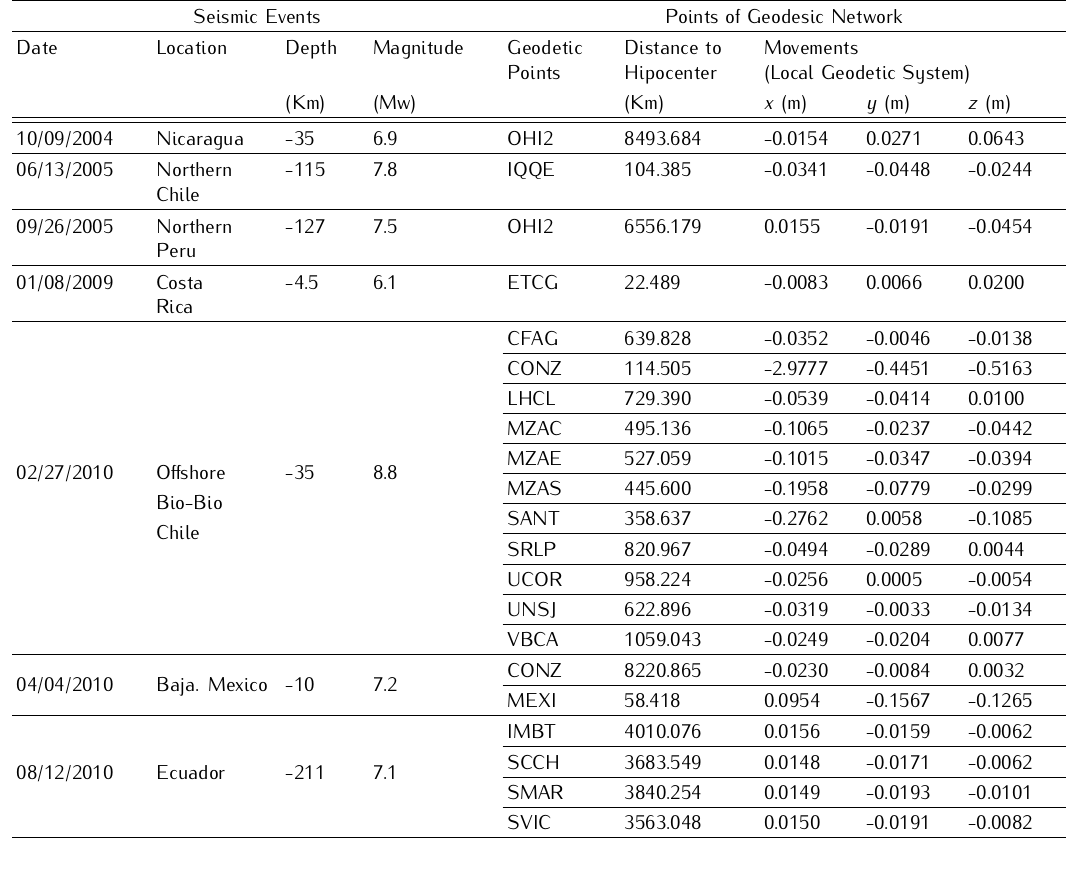
Table 2. Points of the SIRGAS-CON network that were considered unstable between pre- and post-seismic periods. Seismic Events